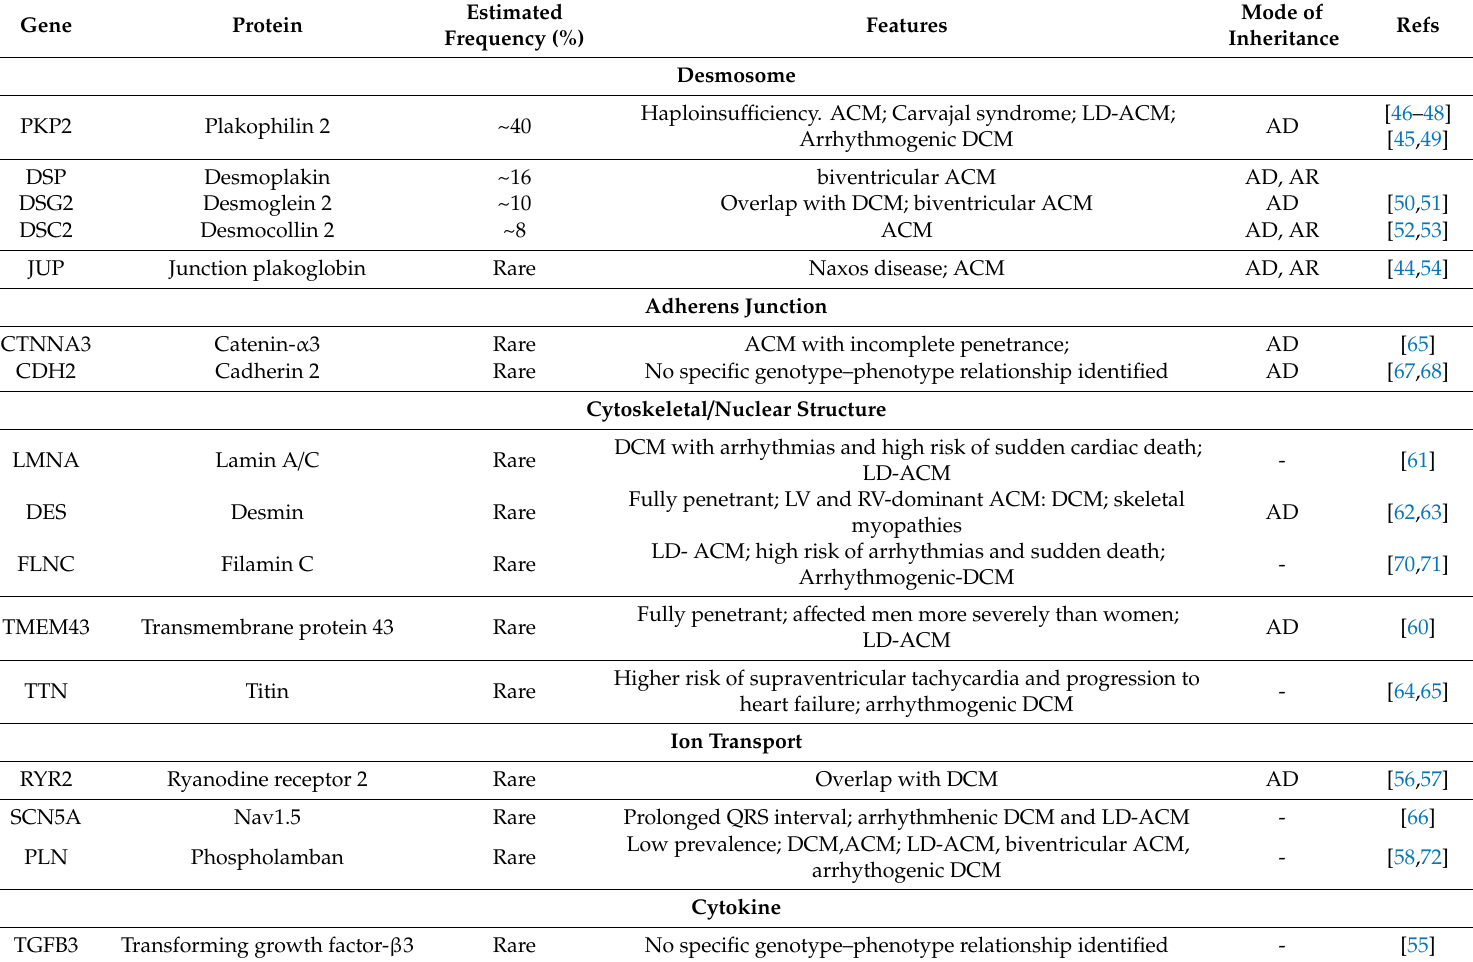
Table 1. List of ACM causal